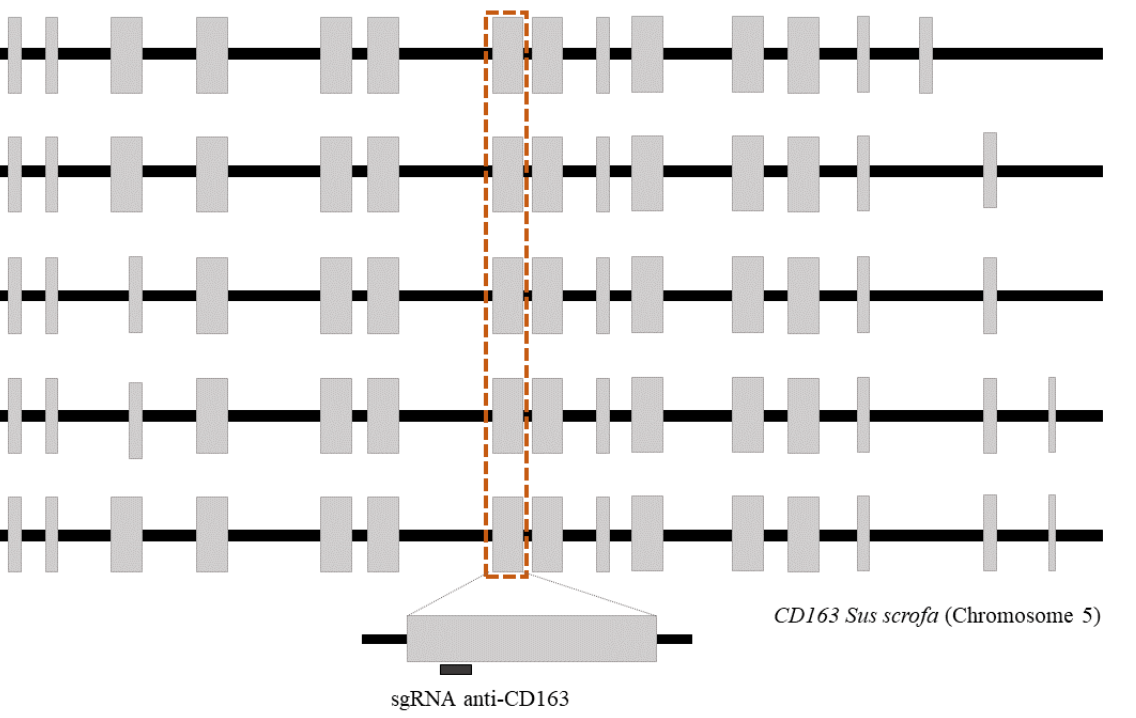
Figure 1. Schematic representation of CD163 isoforms described in Sus scrofa (NC_010447.5). Gray boxes represent exons and black boxes represent introns. The dotted line shows exon 7, where the target region is located.